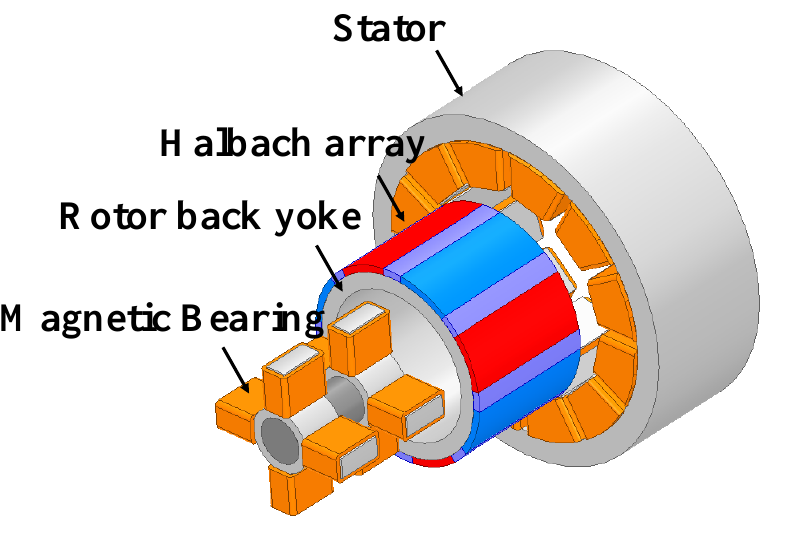
Figure 2. Structure of integrated magnetic bearing motor.